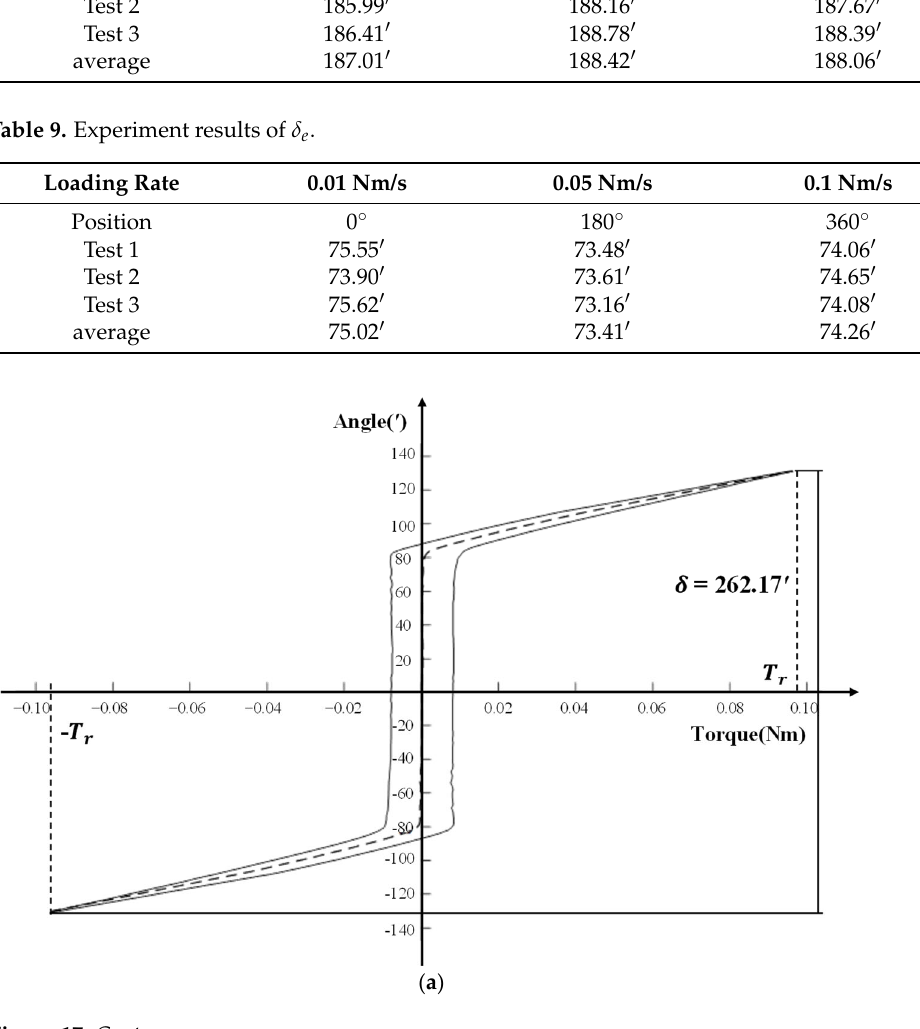
Table 6. Experiment results of 𝛿 (cid:3032) .